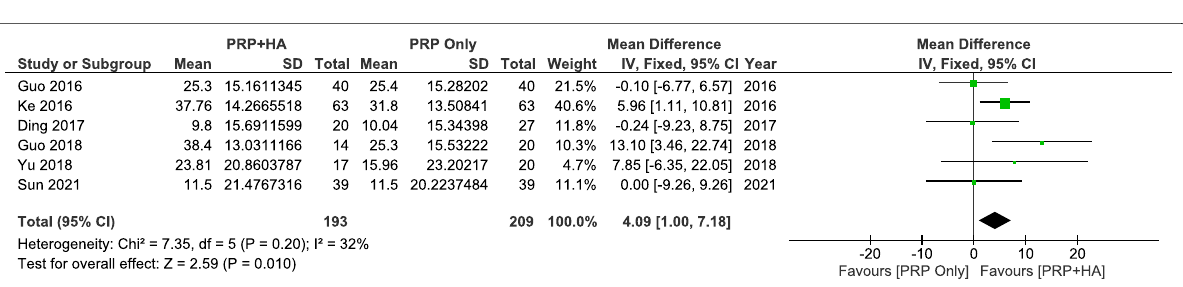
HA and PRP post treatment +